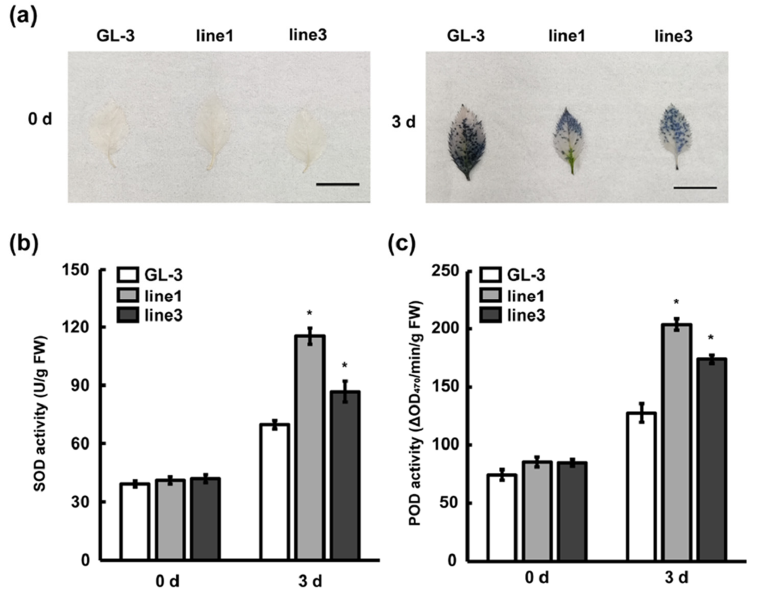
Figure 6. Changes in ROS content and biochemical characteristics during C. gloeosporioides infection. ( a ) NBT staining of ‘GL-3 ′ and MIR390b -overexpressing plants’ leaves under C. gloeosporioides infection, black bars = 1 cm. ( b ) The activity of SOD in ‘GL-3 ′ and MIR390b -overexpressing plants during C. gloeosporioides infection. The vertical bars represent SDs ( n = 3). ‘*’ represents p < 0.05 (Student’s t -test). ( c ) The activity of POD in ‘GL-3 ′ and MIR390b -overexpressing plants during C. gloeosporioides infection. The vertical bars represent SDs ( n = 3). ‘*’ represents p < 0.05 (Student’s t -test).